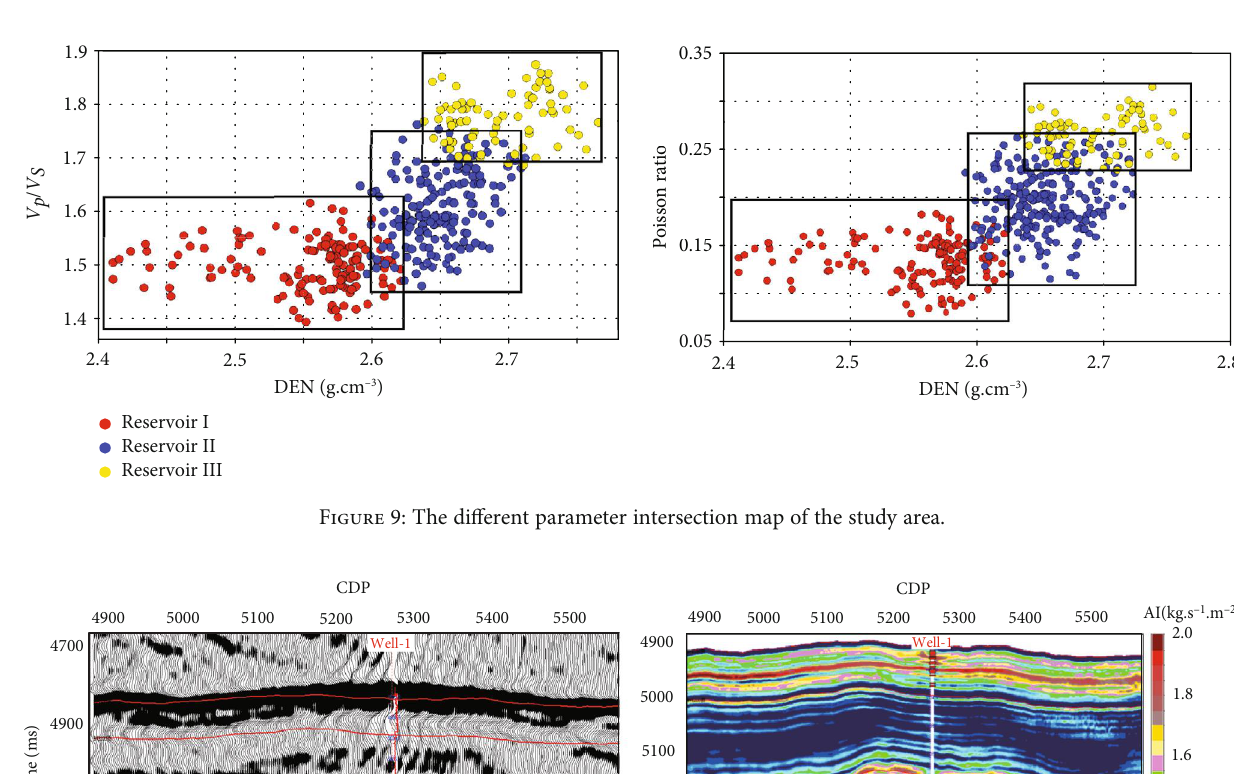
Figure 8: Di ff erent lithological velocities and natural gamma intersections in the study area.